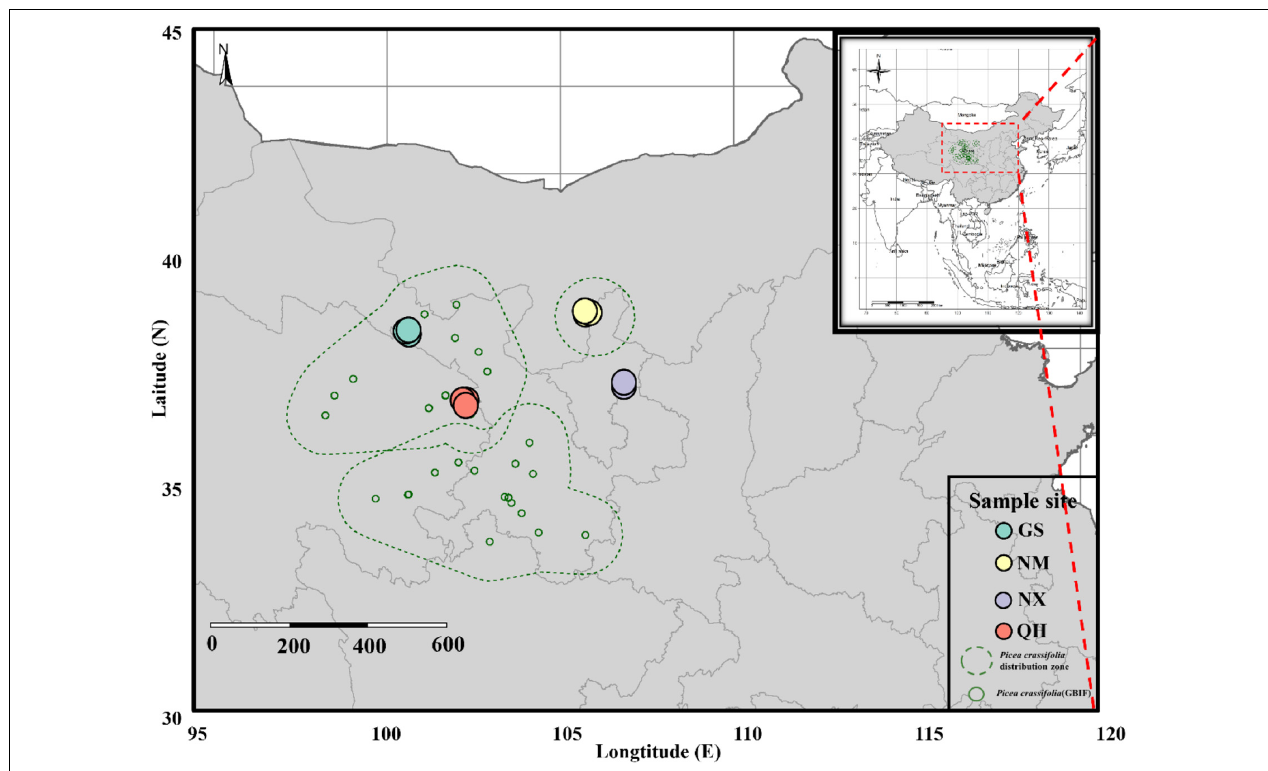
FIGURE 1 | Map of sampling site locations in